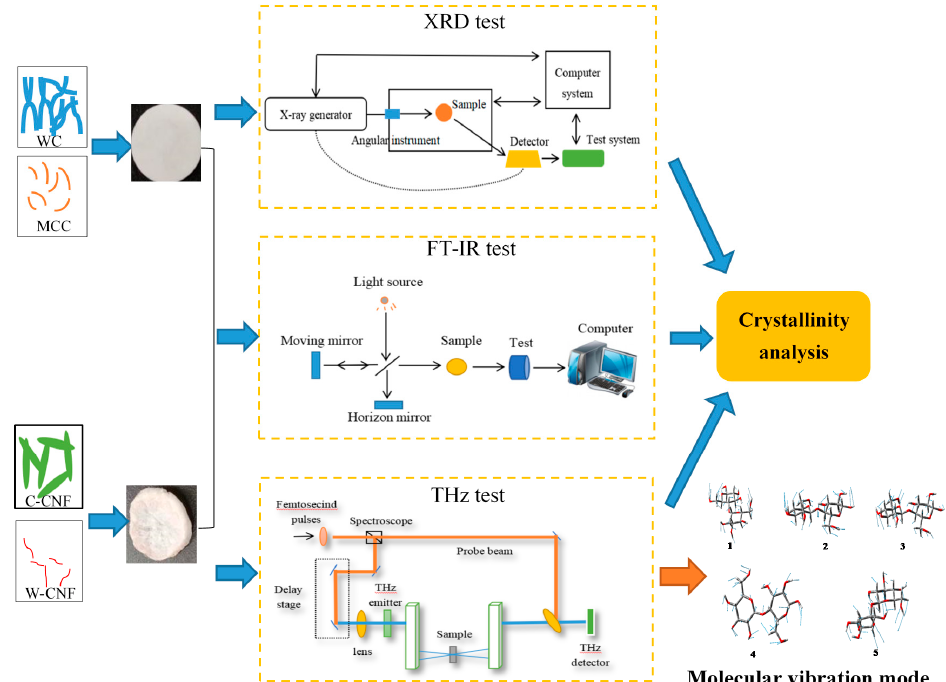
Figure 1. Schematic illustration of description of the entire